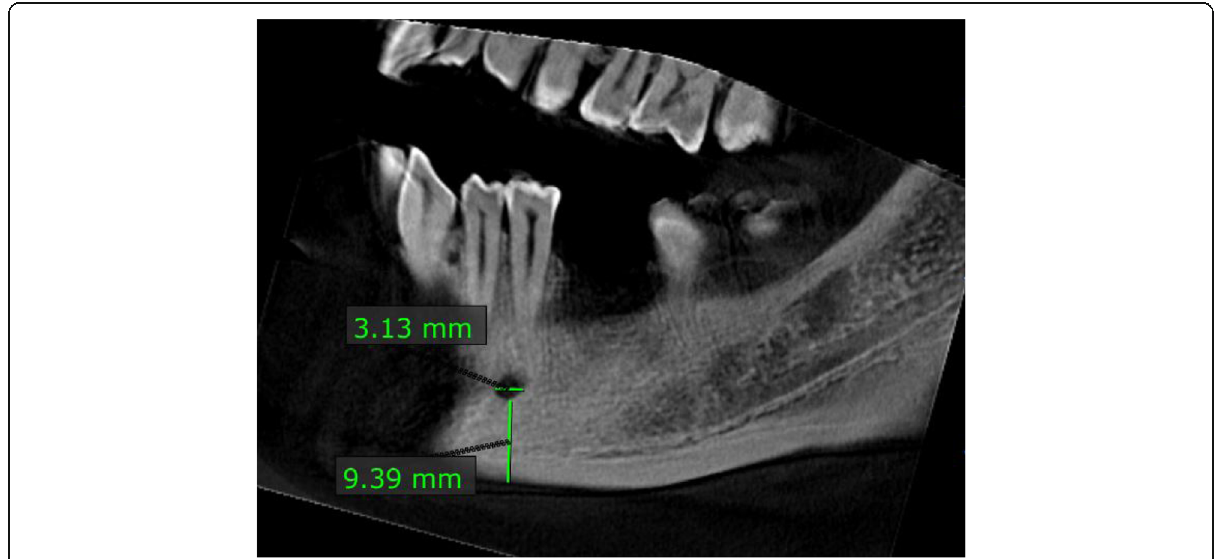
Fig. 3 Modified sagittal image showing measurement of the width as well as distance of the MF from the inferior border of the